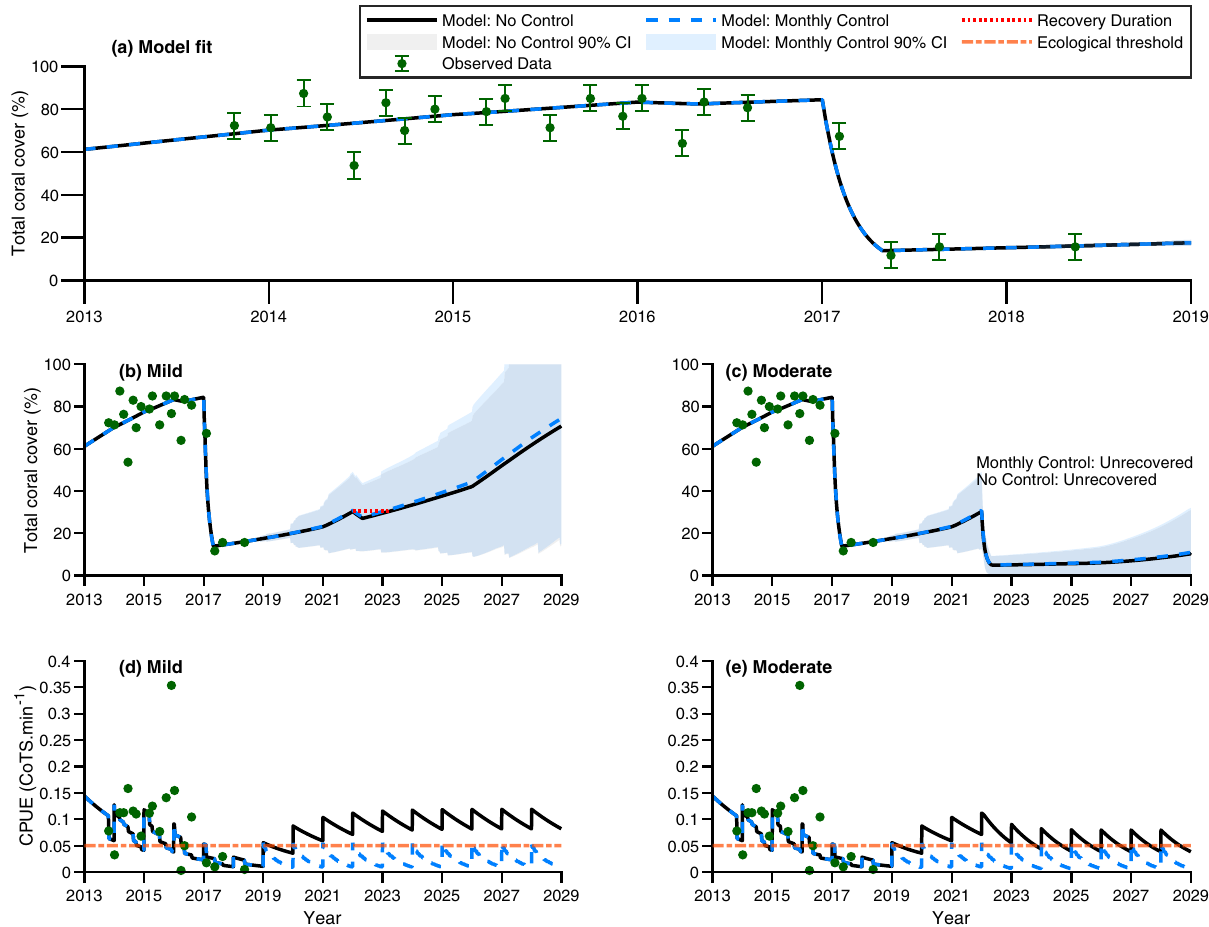
Fig. 3 Management site 2 model fi ts and total coral cover (%) and catch-per-unit-effort (CPUE; CoTS.min − 1 ) of crown-of-thorns star fi sh (CoTS) trajectories under no manual control vs monthly manual control given no adaptive capacity ( A = 0). In all panels, black solid lines de fi ne the no control scenario and the blue dashed line de fi nes the controlled scenario. a The model fi t to total coral cover for the management site (data points plotted with error bars depicting ± 90% CI; green points and error bars). Each data point constitutes a single observation. Variance for the site was calculated at the Maximum Likelihood Estimate (MLE) which was simultaneously fi tted to n = 539 observations (both coral cover and CoTS CPUE, see Supplementary Table 7). The 90% CIs were calculated based on the variance obtained for Management site 2 ’ s coral cover series and the number of observations in the series n = 21. b , c Total coral cover trajectories under different thermal stress levels expressed as Degree Heating Weeks (DHW 2 4 ; 7 f 2022. Mean trajectories are presented ± 90% CI depicted as errors bands ( n = 80 simulations; grey shading is a 90% CI error bands for the no control scenario, blue shading is 90% CI for the controlled scenario). If coral cover recovery to pre-perturbation levels is not observed by year 2029